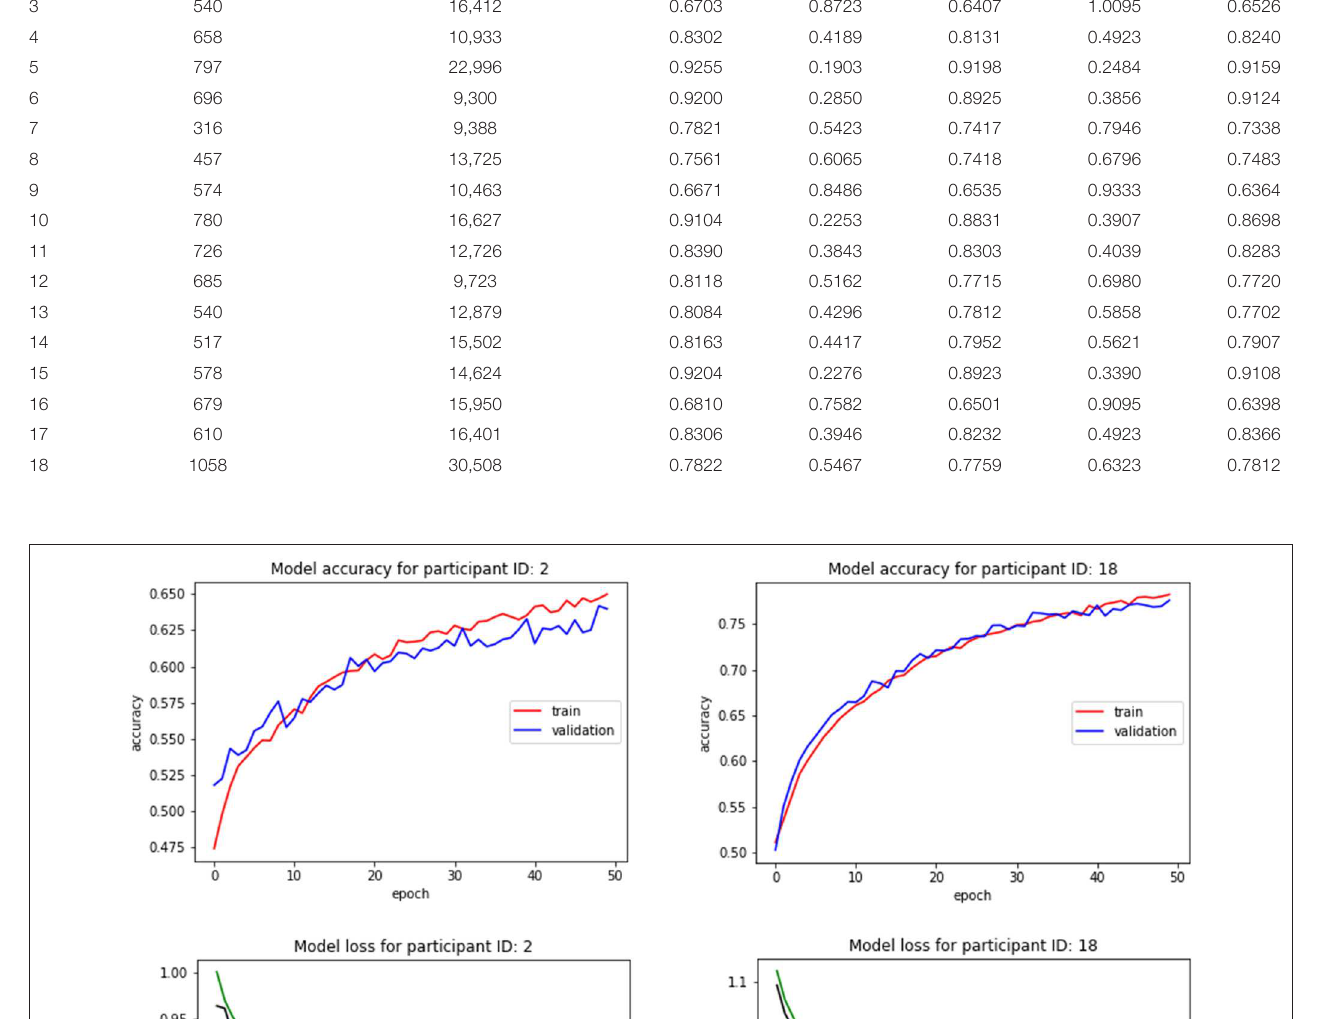
Frontiers in Robotics and AI |